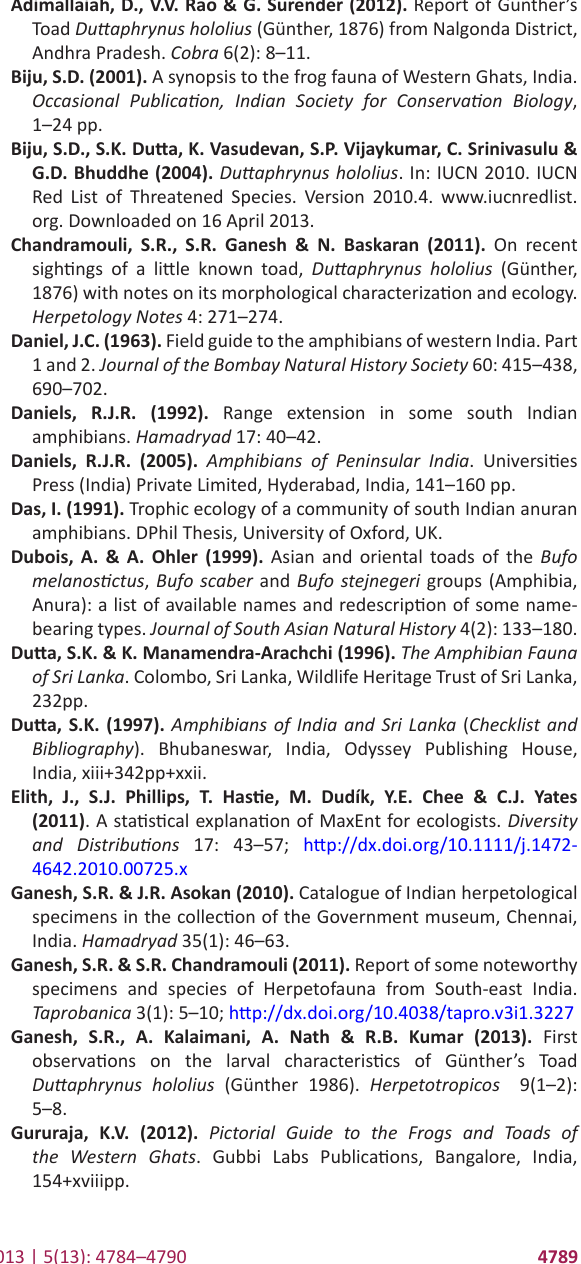
specimen from Chennai, southeastern India